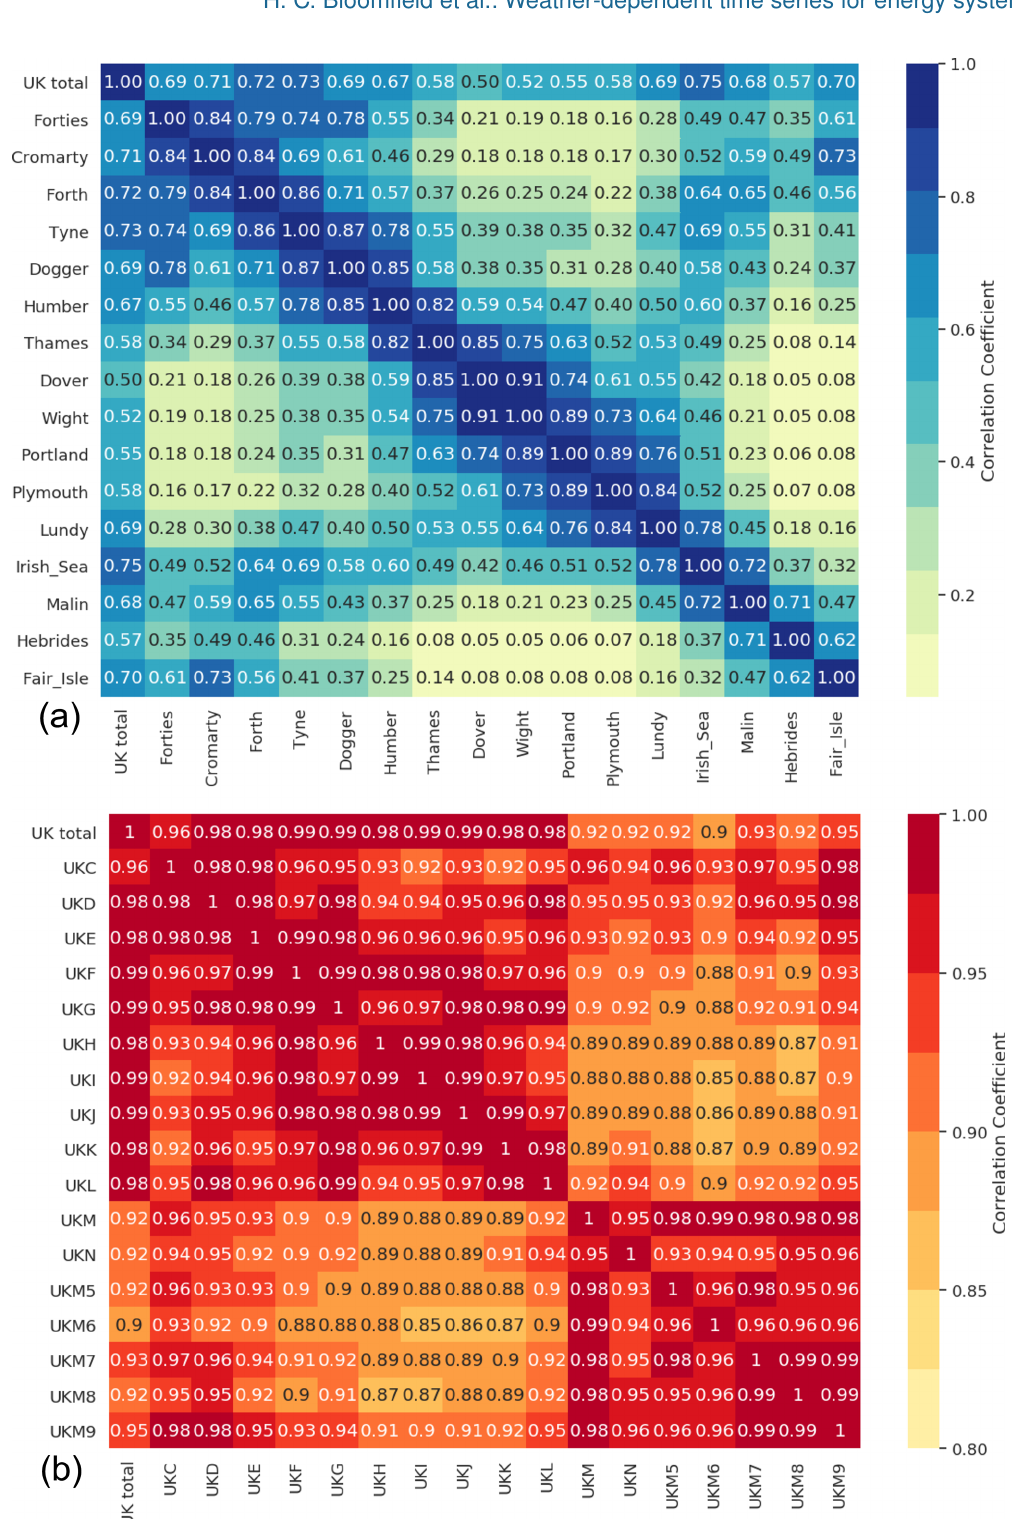
Figure 7. Pearson correlation coefficient heat map of (top) hourly offshore wind capacity factor time series from the Met Office shipping zones, compared to the UK location-weighted total, and (bottom) hourly solar power capacity factor for NUTS1 and NUTS2 zones compared to the UK location-weighted total.